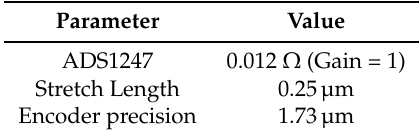
Table 3. Minimum values for experiment